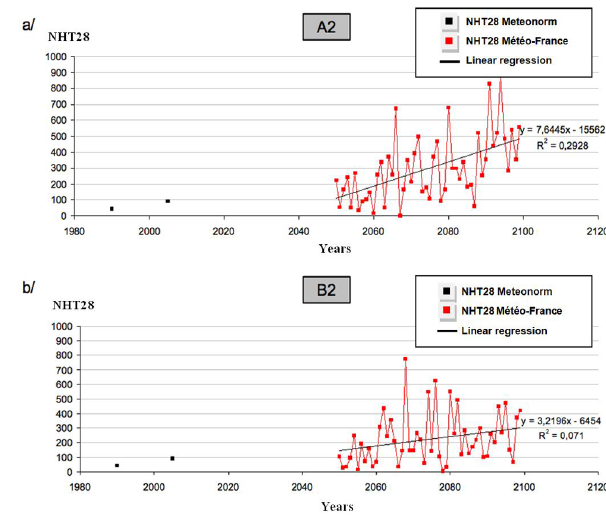
Fig. 4. Number of hours when T > 28 ◦ C for the scenarios A2 (a) and B2 (b) , in